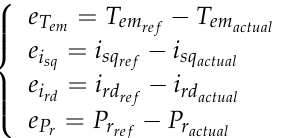
Figure 34. Active power injected into the grid.